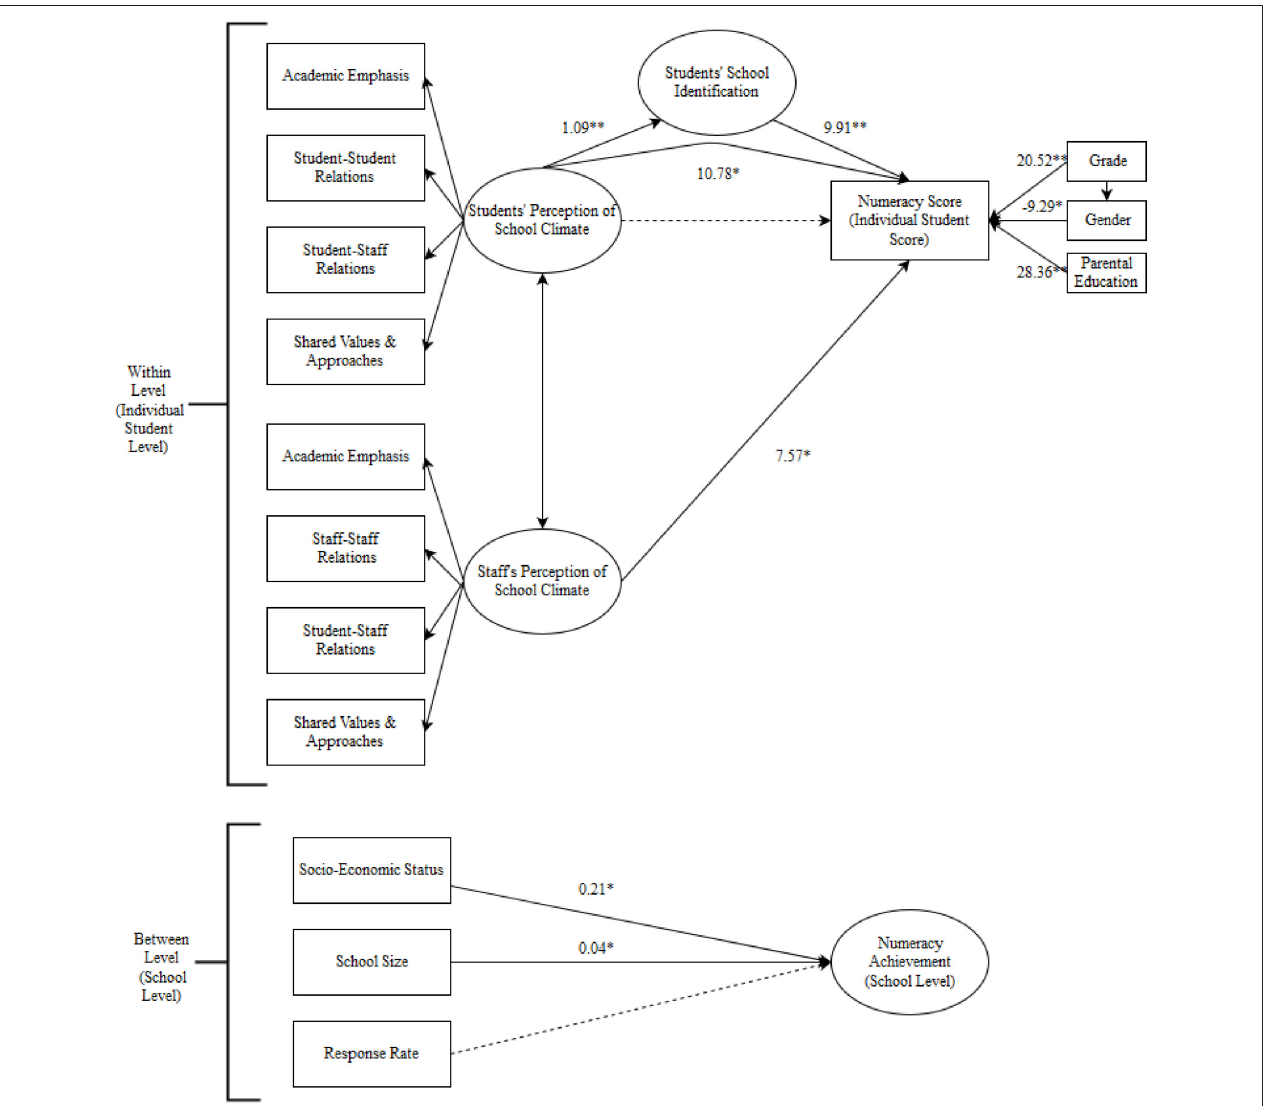
FIGURE 2 | Model 5: Multilevel SEM of numeracy scores with student and staff school climate perception predictors, a mediator of student school identification, and demographic covariates at the student and school level. Error terms, correlations, and related coefficients are ommitted for simplicity. Gender: Male = 0, Female = 1; Parental education: below university degree = 0, university degree or higher = 1. Coefficients are unstandardized. * p < 0.05; ** p <